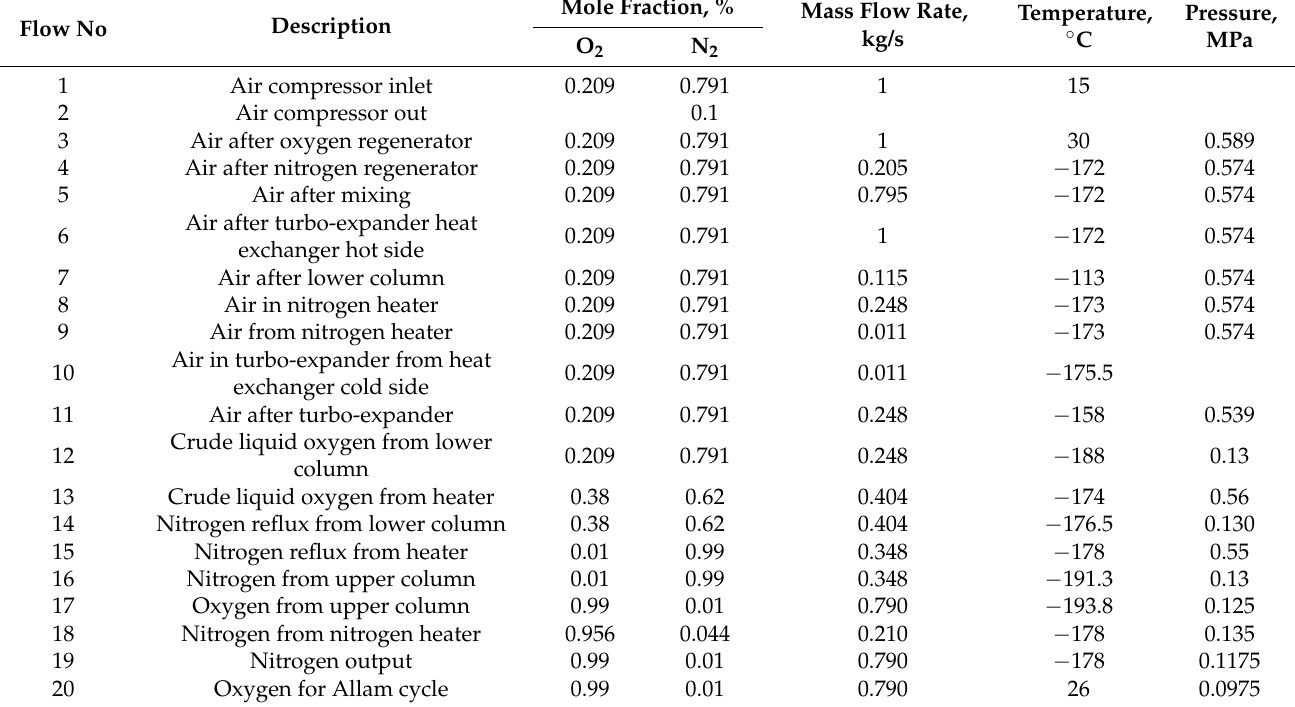
Table 2. ASU flow